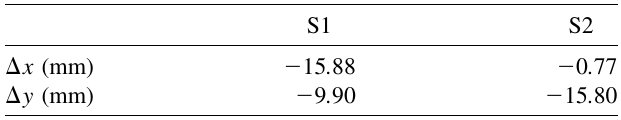
TABLE I. Approximation of x and y displacements of the two solenoids relative to the ideal beam axis. S1 S2